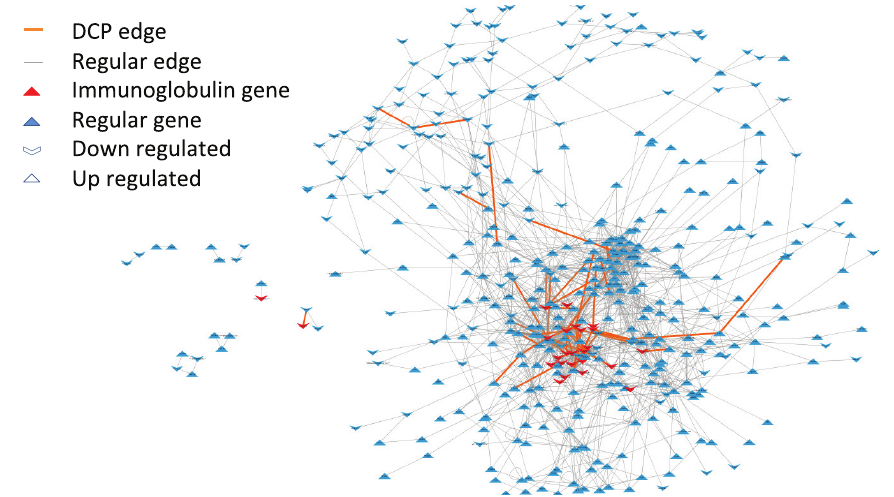
Figure 1. Co-expression networks for BcKO data. The nodes are composed by DEGs and the edges represent significant correlations between nodes. The causal genes (immunoglobulin genes) and the DCP edges are concentrated in the high connectivity region with several causal genes forming